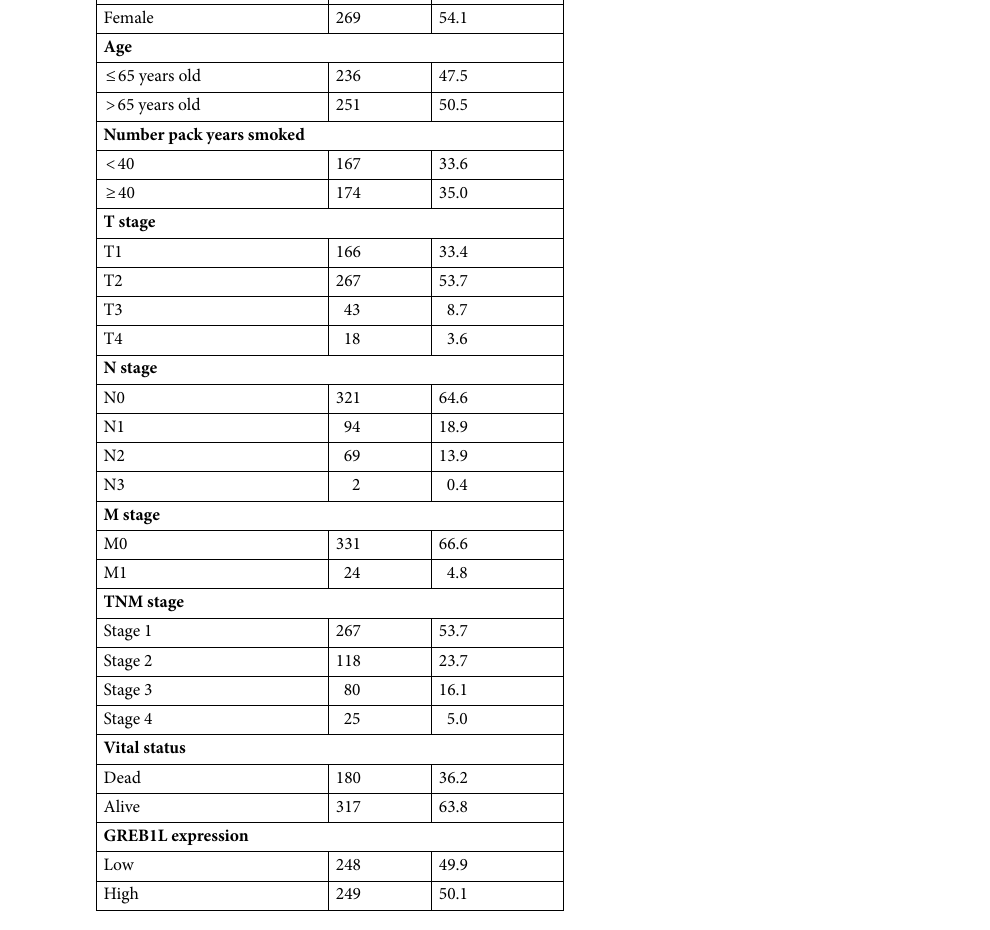
Table 1. Clinical characteristics of LUAD patients in